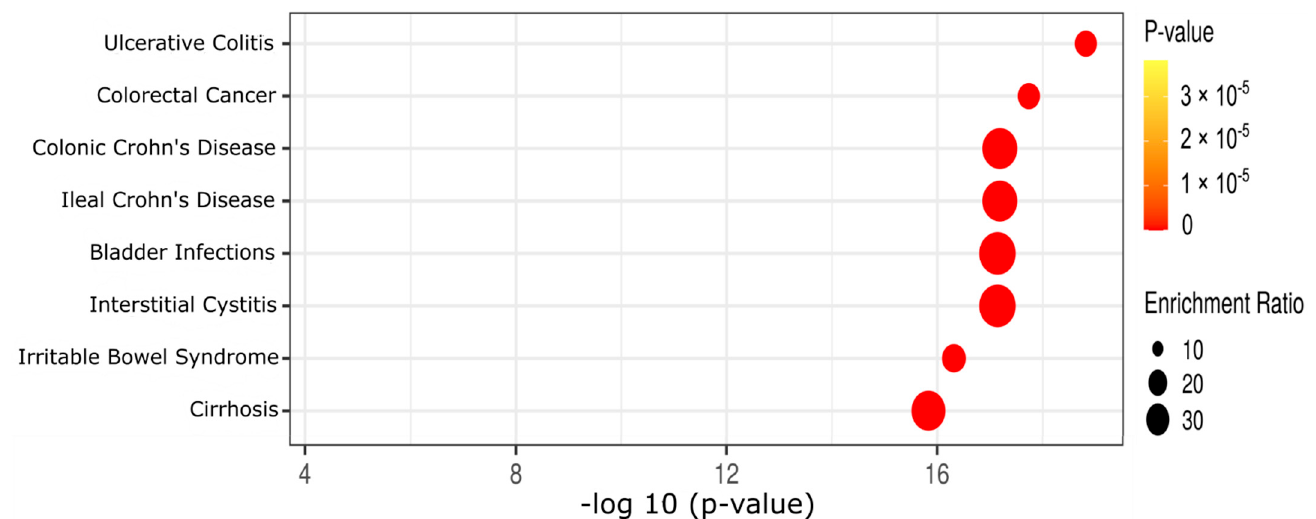
Figure 3. Metabolite set enrichment analysis of the 65 differential metabolites. Only the top 8 of 27 statistically significant metabolite sets (Table S5, with Q-statistic) are listed here, and the p -values are obtained by metabolite set enrichment analysis and adjusted by FDR methods.